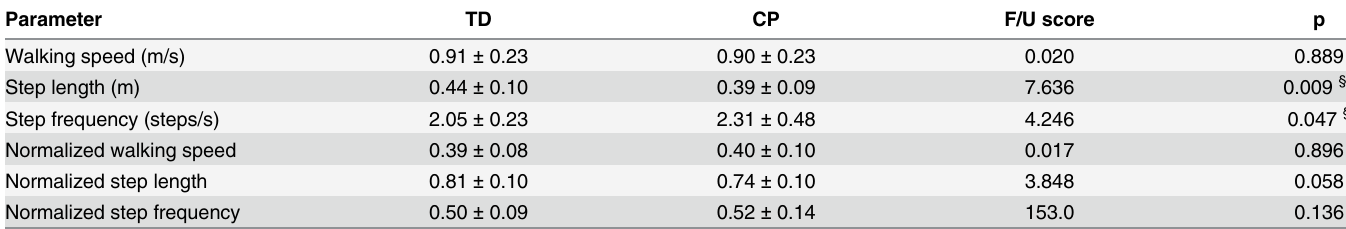
Table 1. Gait parameters obtained for both the TD and CP groups.